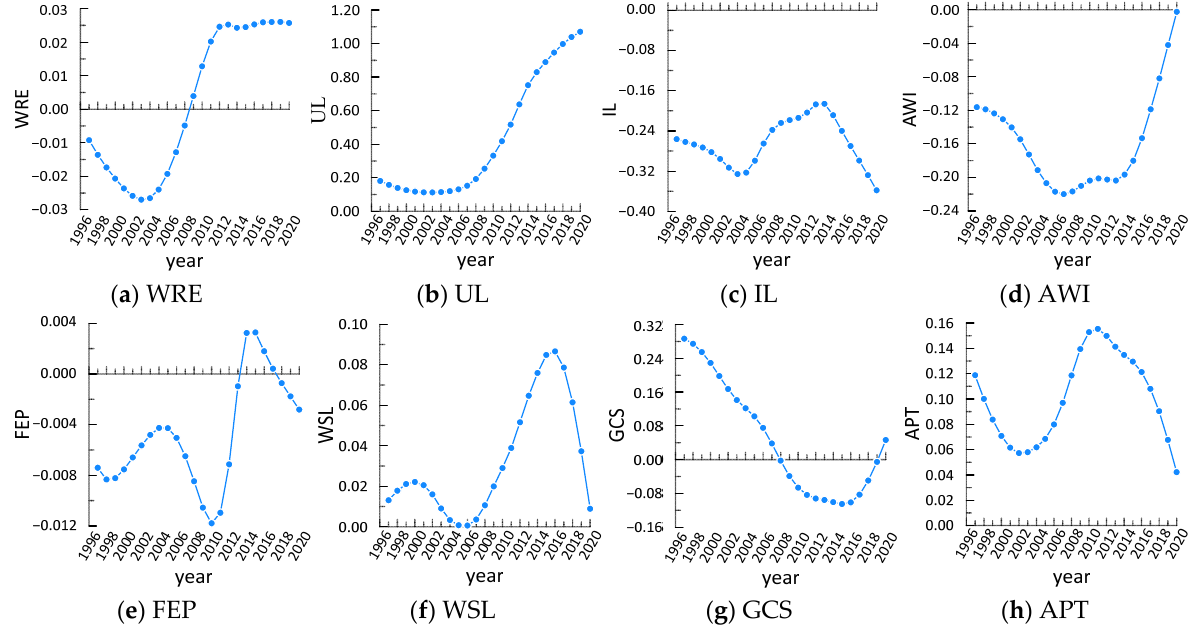
Figure 7. Temporal evolution characteristics of each influencing factor from 1997 to 2020. Note: The X-axis represents year and the Y-axis represents the coefficients of each influencing factor.